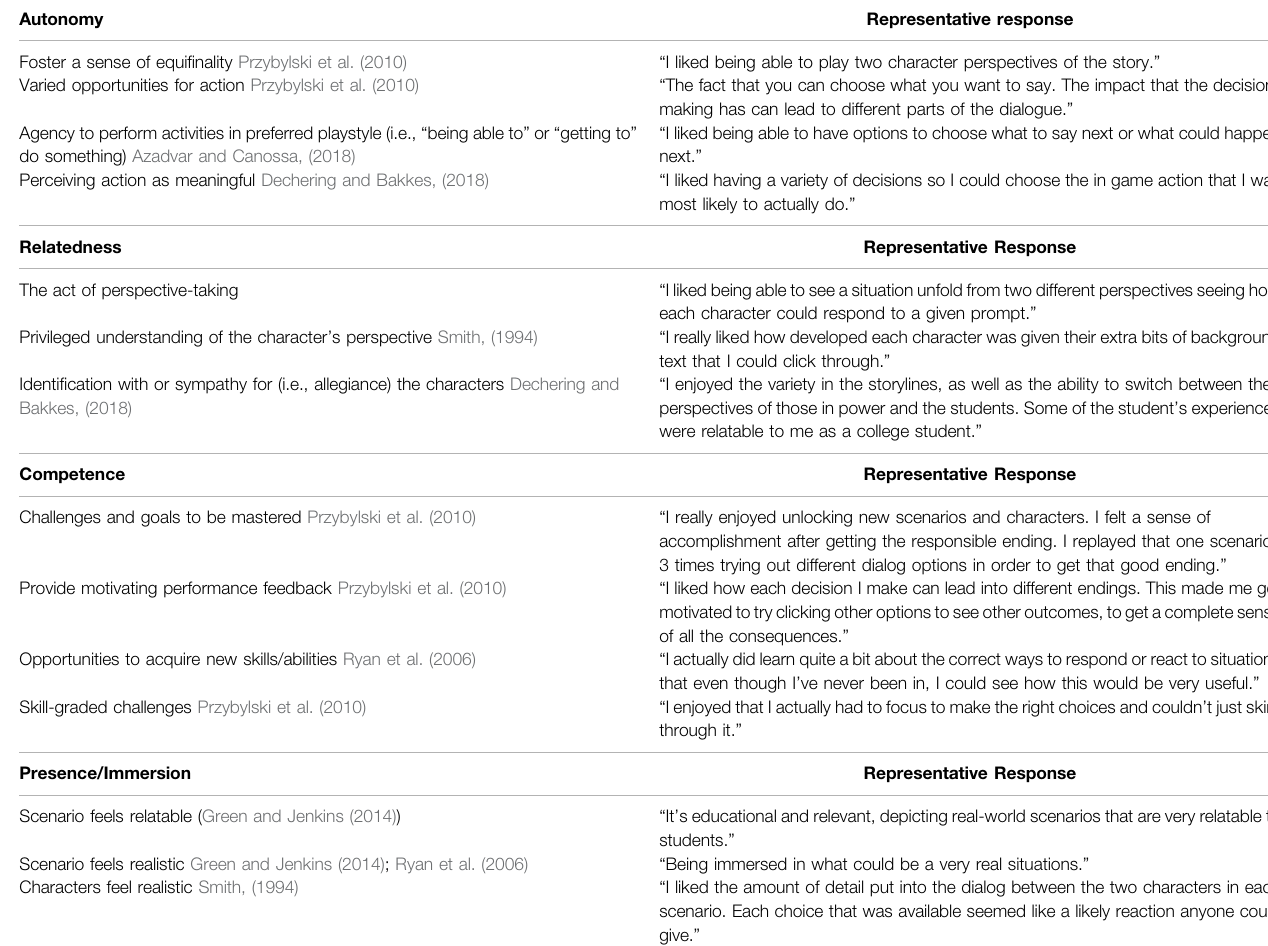
TABLE 1 | Rubric used for scoring qualitative answers (left column) and corresponding “ MOST enjoy ” representative responses from study participants